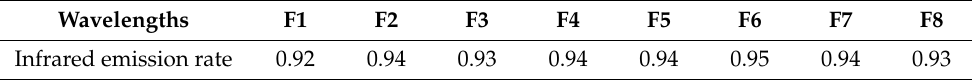
Table 8. Infrared emissivity of MIRP at different